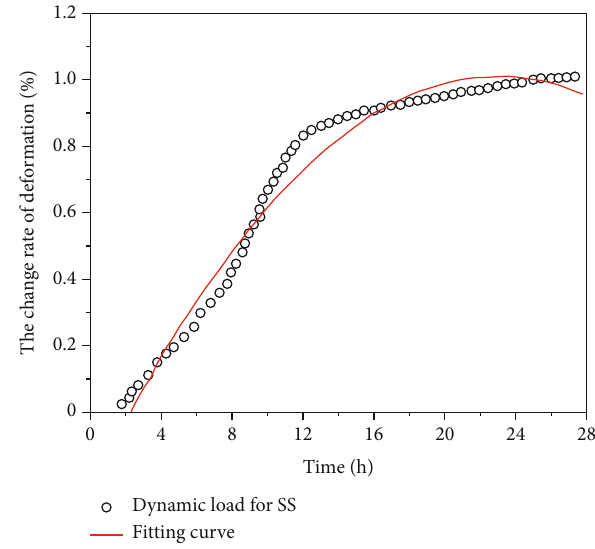
Figure 16: The change rate of deformation and time fi tting curve of